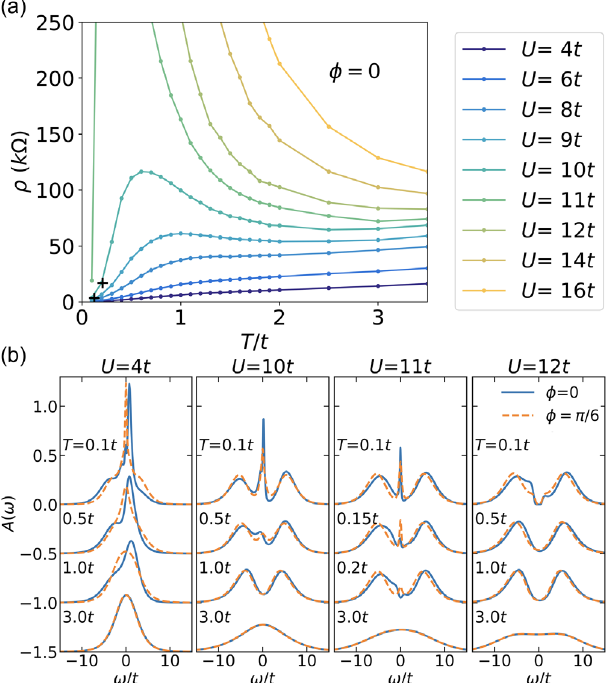
FIG. 2. (a) Temperature dependence of resistivity at half filling for ϕ ¼ 0 with different interactions. The black cross marks the magnetic transition temperature for U=t ¼ 9 , 10. (b) Spectral function for ϕ ¼ 0 (solid line) and π = 6 (dashed line) at repre- sentative temperatures for different